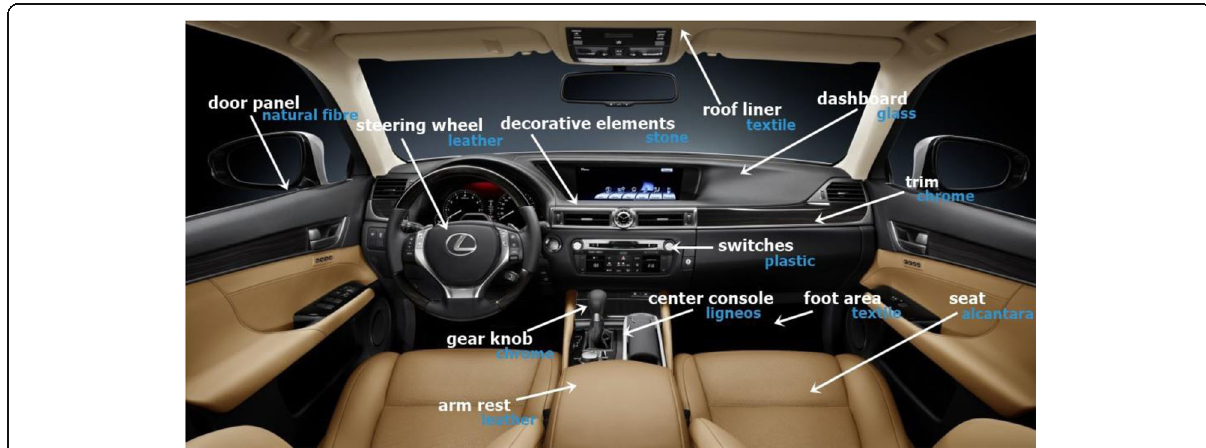
Fig. 8 Interior components with corresponding materials. Source: Barnes-Clay,